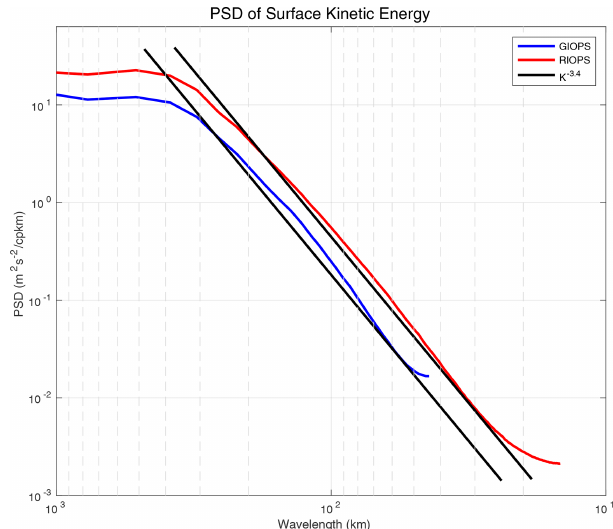
Figure 13. Power spectral density (PSD) of the surface kinetic en- ergy in RIOPSv2 (red line) and GIOPSv3 (blue line). The PSD is calculated using both zonal and meridional surface current fields over a box covering the Gulf Stream region (48.8–66.0 ◦ W, 32.3– 45.0 ◦ N) using weekly instantaneous SLA fields over the period 1 January 2016 to 31 December 2018. The k − 3 . 4 line is shown in black and adjusted to fit the curves for RIOPSv2 and GIOPSv3. The wavelengths at which the PSD curves depart from the k − 3 . 4 line are shown for both the high and low wavelength